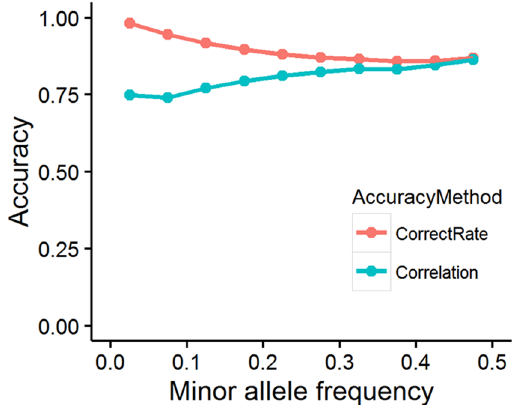
Figure 1. Evaluation of imputation accuracy MAF. The x-axis is the MAF range from 0 to 0.5, and the y-axis is imputation accuracy denoted by the correct rate (CR) and correlation. The pink line shows the CR, which was calculated as the number of alleles imputed correctly divided by the total alleles at each locus across MAF. The blue line shows the correlation between true and imputed genotypes at each locus across MAF.